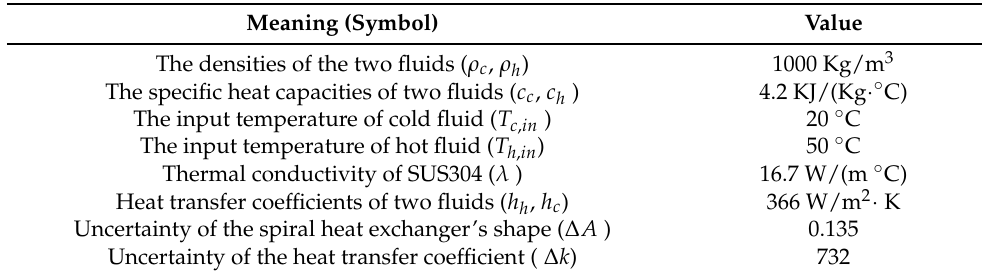
Table 1. Simulation parameters of the spiral-plate heat exchanger.